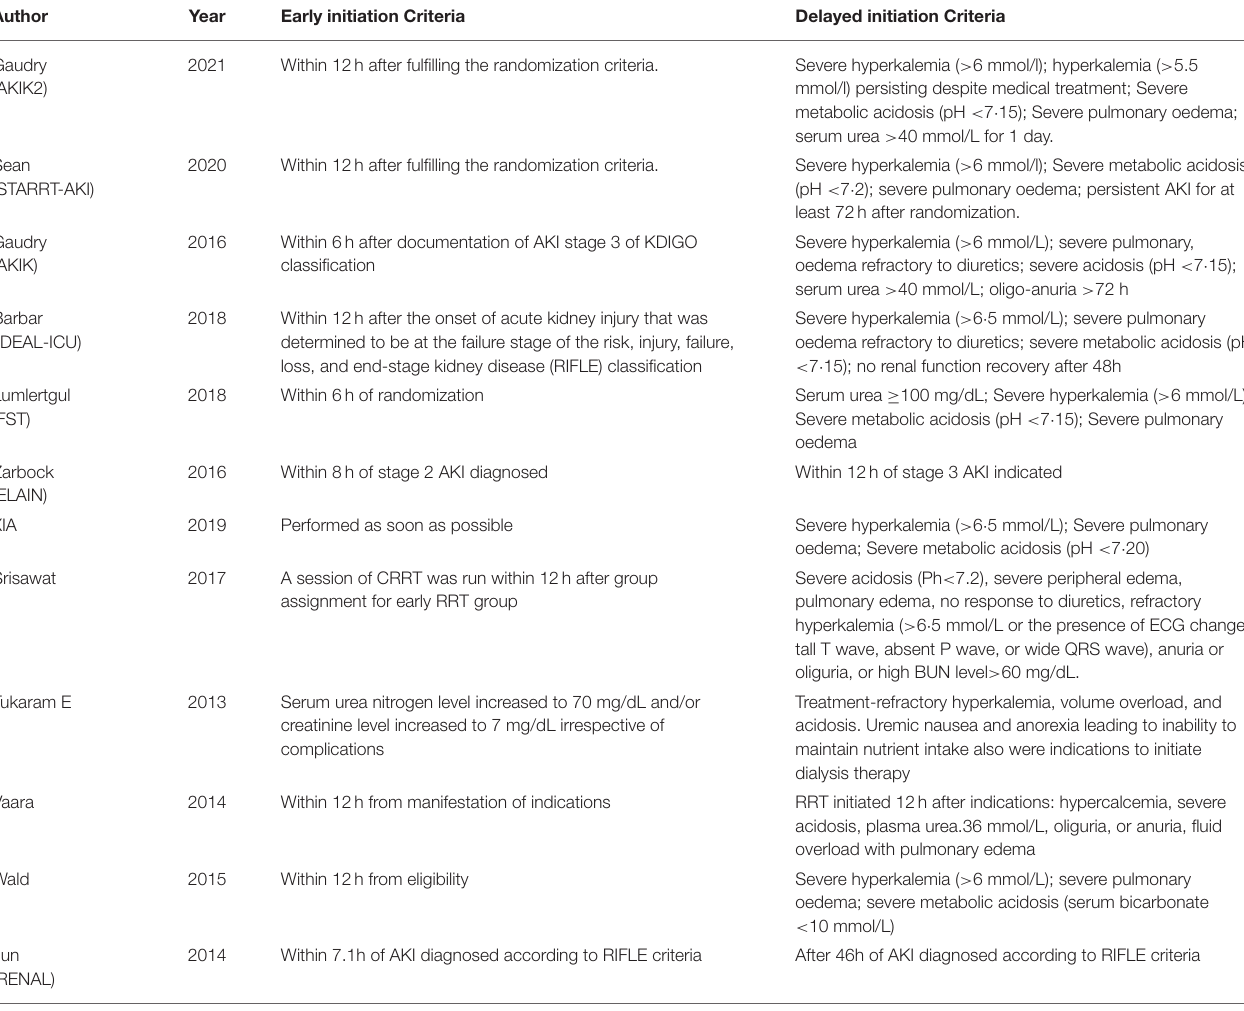
TABLE 2 | Definitions of early and delayed renal replacement therapy (RRT) in individual studies. Author